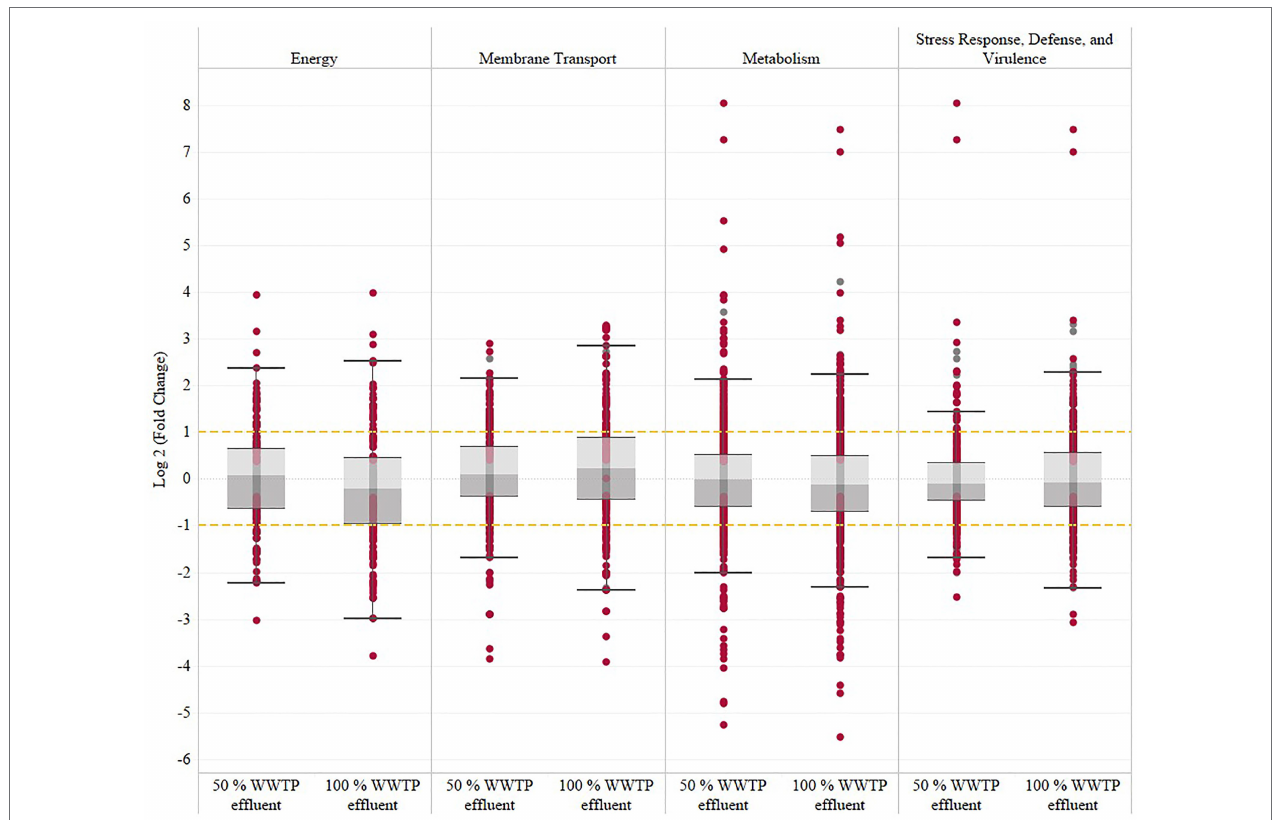
FIGURE 1 | Summary of V. vulnificus transcriptomic response to wastewater effluent exposure across the energy, membrane transport, metabolism and stress response, defense, and virulence categories established by the PATRIC analysis tool. This table shows the overall log 2 fold change at 50 and 100% wastewater effluent relative to the 0% wastewater effluent control. The significantly regulated genes (FDR-adjusted value of p ≤ 0.05) are represented with garnet dots, and gray dots represent the non-significant